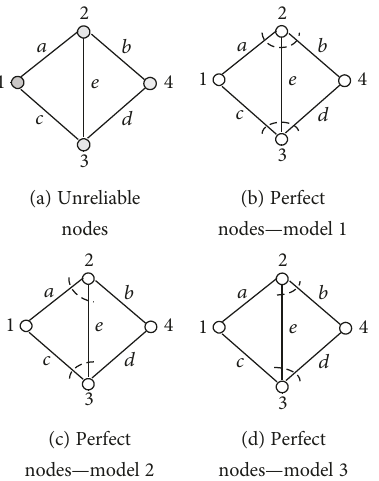
Table 1: Adjusted reliability values for the links in the network.